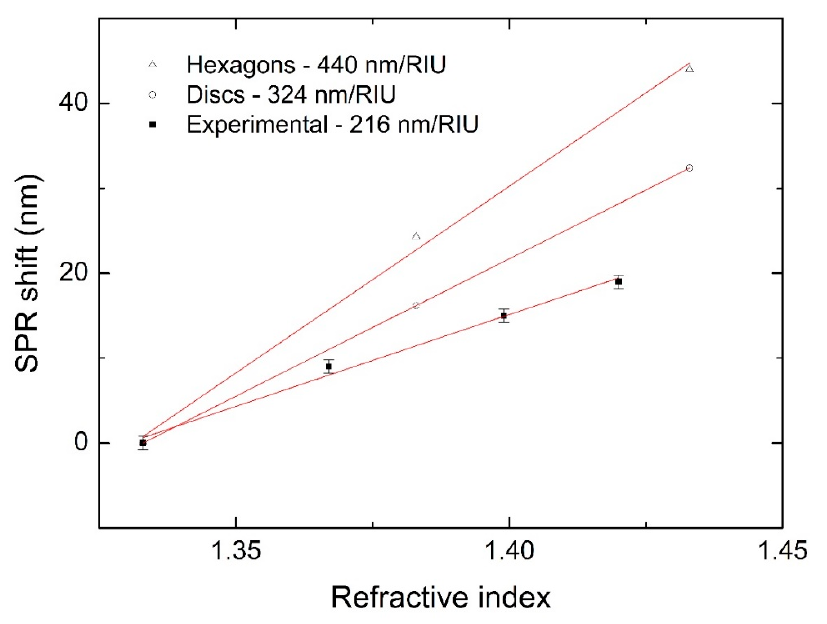
Figure 7. Experimental (full squares) and simulated (empty shapes) SPR shift at different refractive indices.